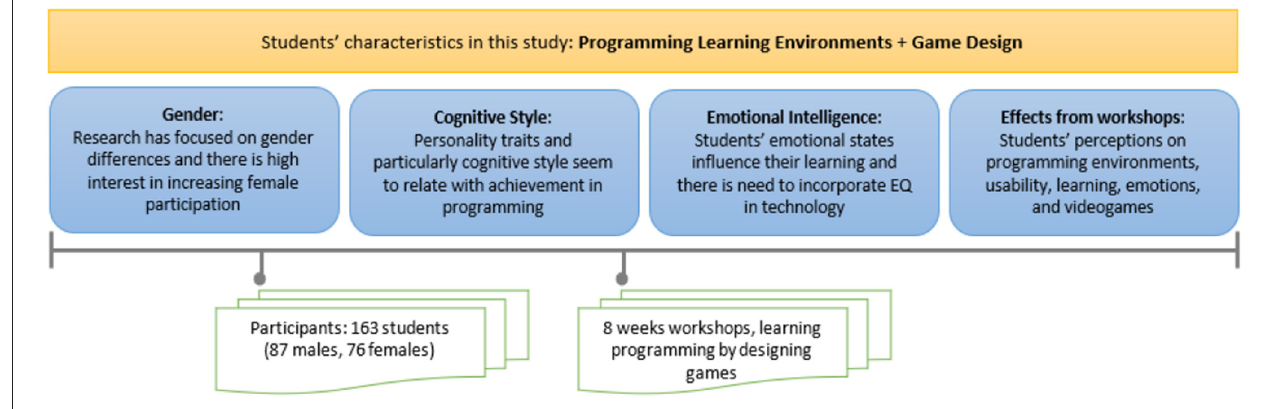
FIGURE 1 | Variables (conceptual model) used in this